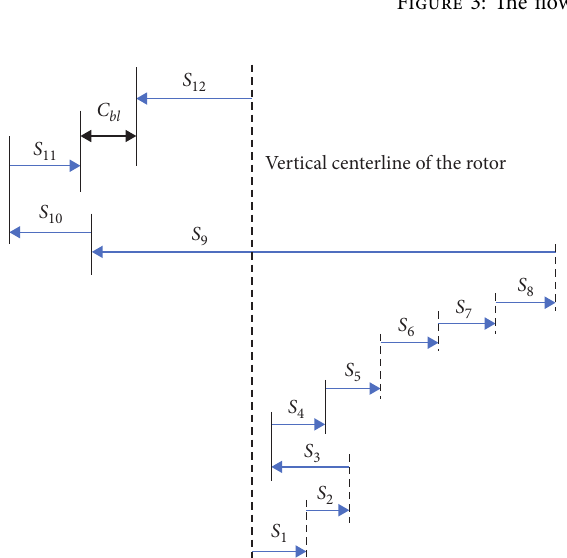
Figure 3: The flow gap of the steam turbine.